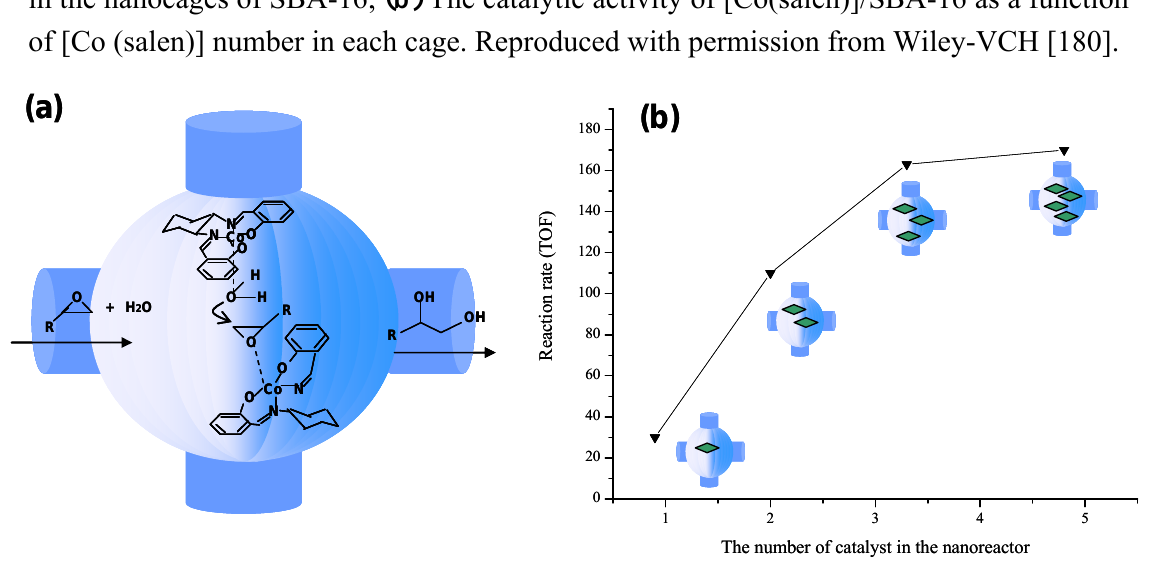
Figure 9. (a) Hydrolytic kinetic resolution of epoxides on [Co(salen)] complexes